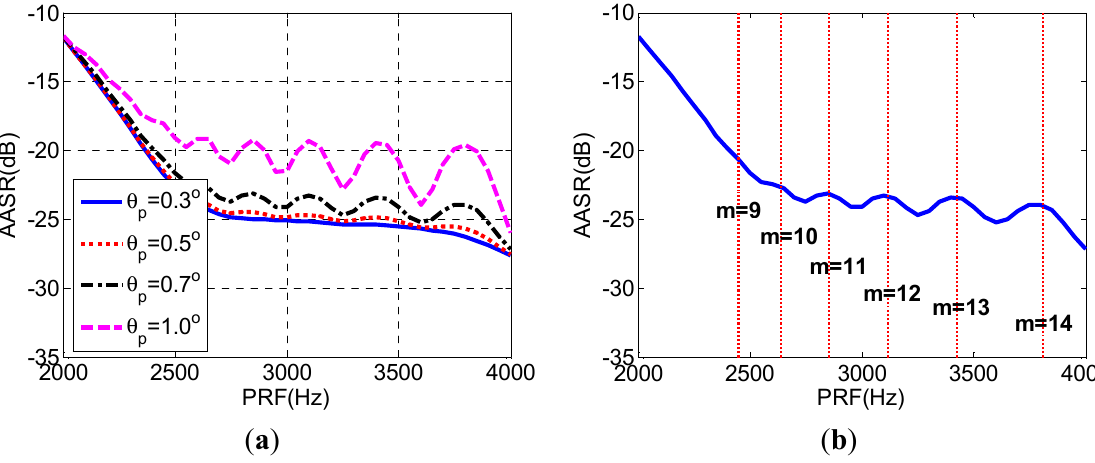
Figure 4. Azimuth ambiguity to signal ratio (AASR) varying with the pulse repetition frequency (PRF). ( a ) With different steering angles; ( b ) With a steering angle of